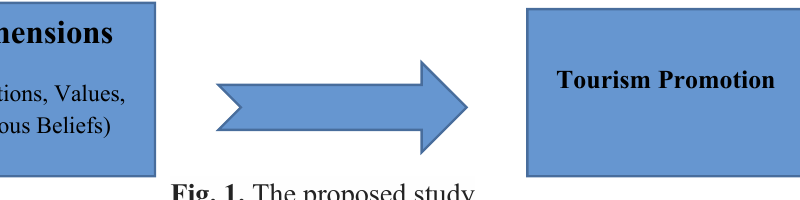
Fig. 1. The proposed